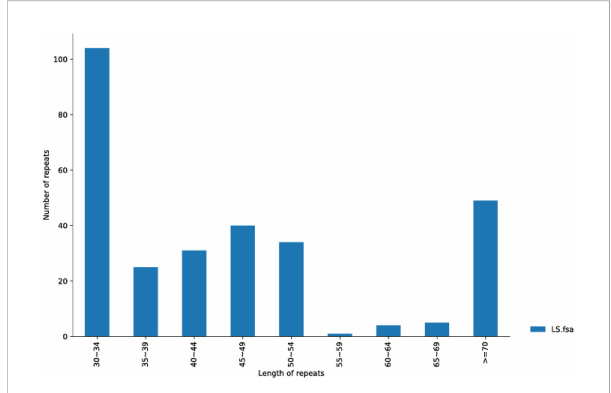
FIGURE 3 Prediction of RNA editing sites in protein-coding genes of mitochondrial genome in A. of fi cinalis . The horizontal axis refers to the type of gene and the vertical axis refers to the number of editing